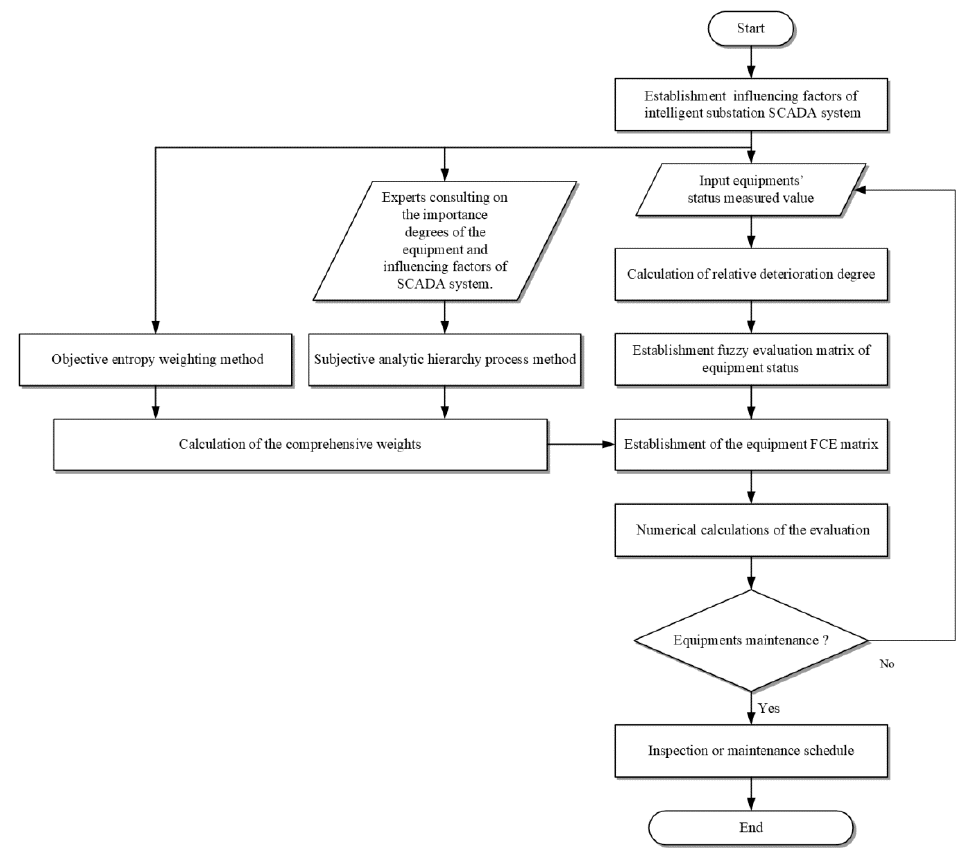
Figure 1. The flowchart of the FCE method.